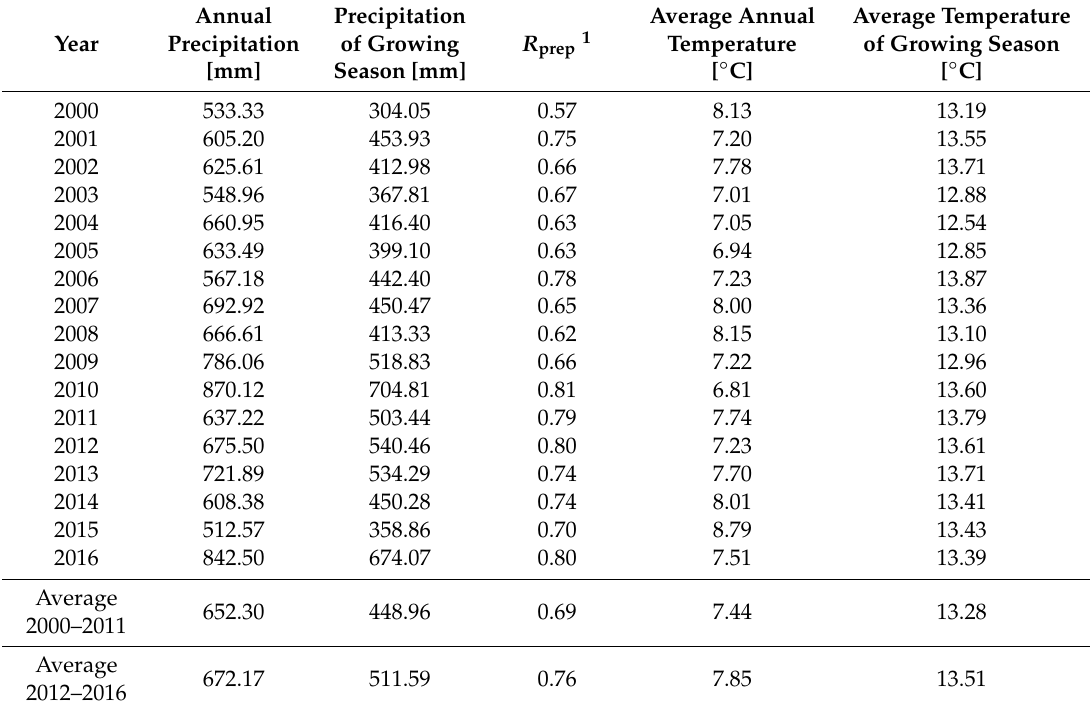
Table 5. Meteorological data from the climatic station located in